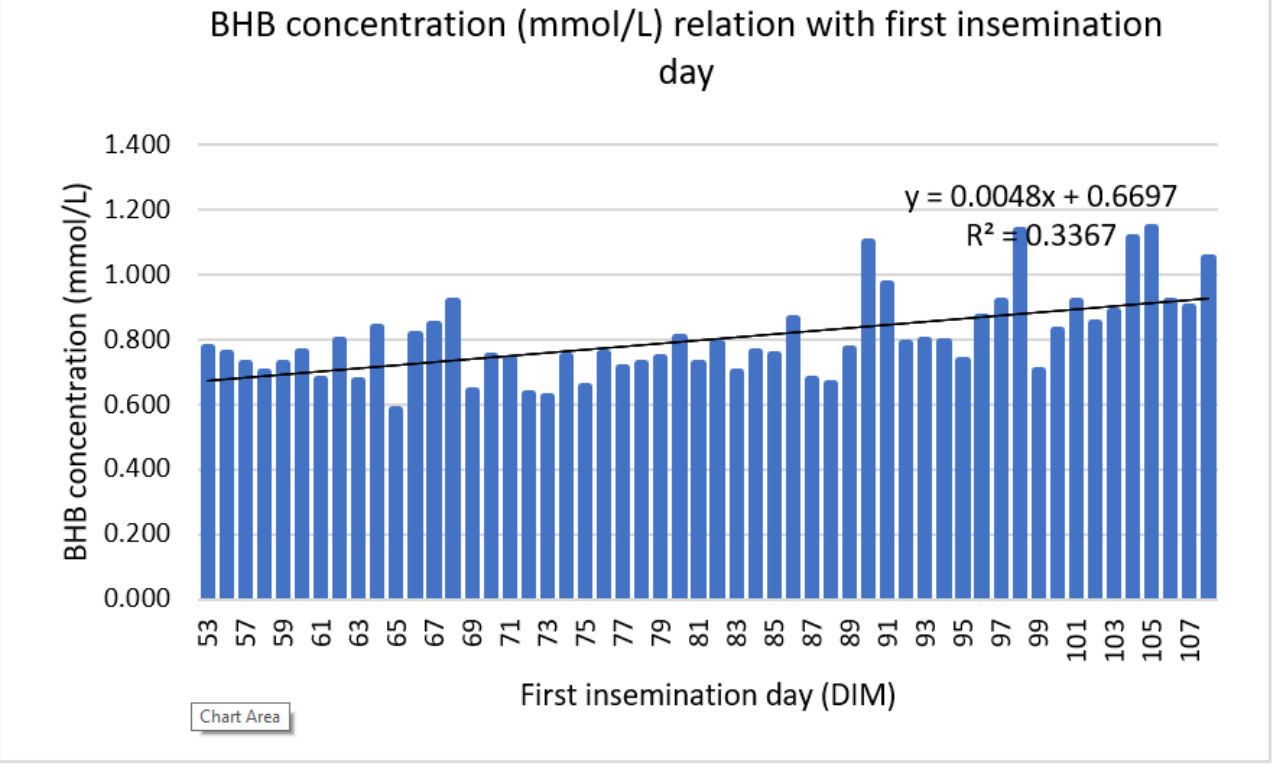
Figure 3. The effect of mean BHB concentration (mmol/L) on second week of lactation on first insemination day. Table 3. The results of insemination rate and first insemination day in different seasons and relationship between insemination rate and BHB concentration and first insemination day and BHB